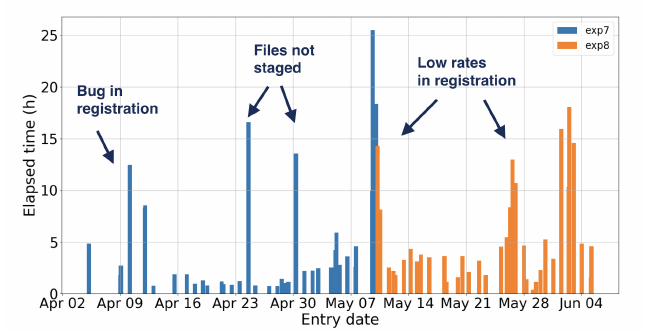
Figure 6. Elapsed time in hours for files being registered and replicated by the Raw Data Management system. Each bar corresponds to a list of files submitted from the o ffl ine system, and the elapsed time corresponds to the time between the files entering into BelleRawDIRAC to its completion with two replicas created. An abnormally long time indicates an issue during the process. So far, we have identified bugs in the registration, files not staged on disk, and abnormally low rates in the registration product of many files submitted at